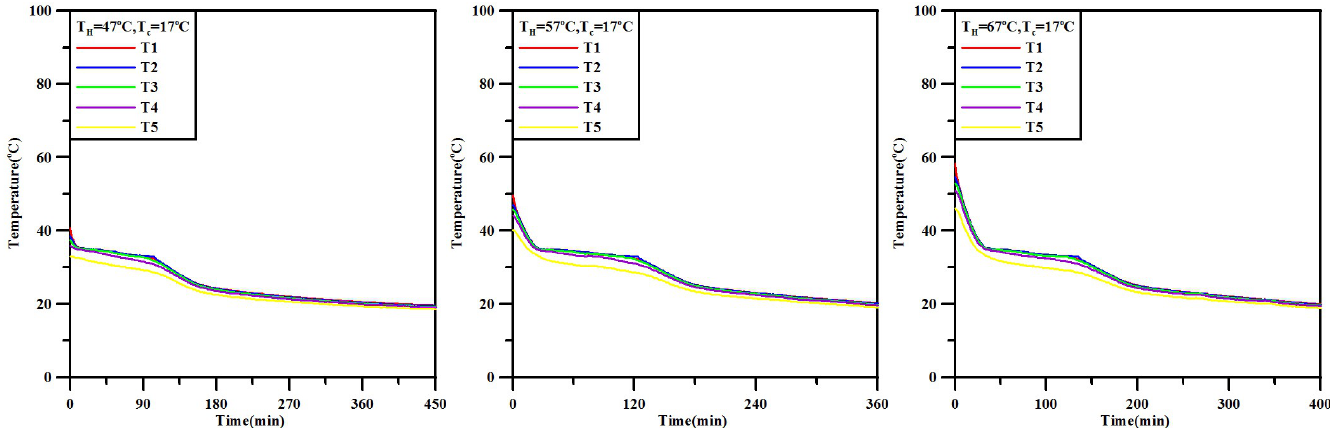
Figure 7. The solidification interface location (melting fraction) and the interior temperature of the mPCM as a function of time at T C = 17 °C after the heat supply was stopped (initial hot wall temperature T H ).